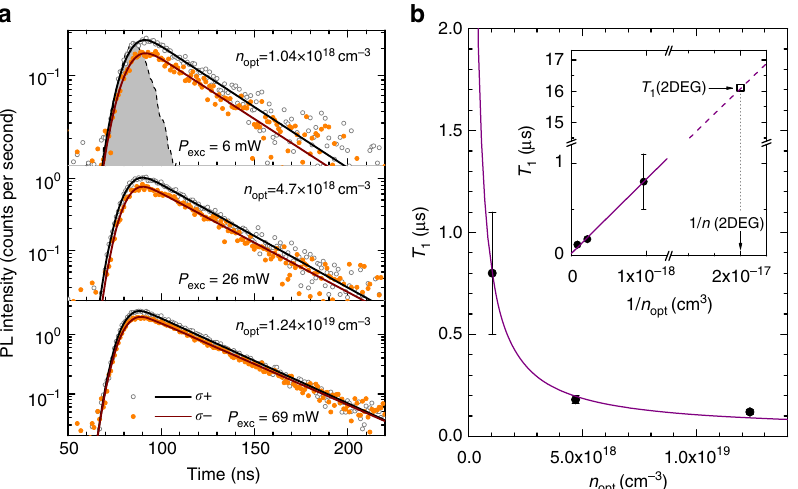
Figure 6 | Estimation of T 1 from time and polarization resolved PL. ( a ) Decay curves of the indirect PL emission from a 20nm thick QW. The filled area corresponds to the laser pulse. Co-circular ( s þ ) and counter-circular ( s (cid:3) ) emissions with respect to the excitation have been obtained at T ¼ 4K, under excitation by 1.165eV circularly polarized laser line. The three panels report data (dots) and fits (lines) of the PL for the various densities of the photogenerated carriers n opt . ( b ) T 1 values (dots) obtained by using the PL data in a . The solid line is a fit of T 1 as a function of 1/ n opt . The inset shows the T 1 (2DEG) obtained by the fit for the electron concentration n (2DEG) pertaining to the n-mod QW studied by